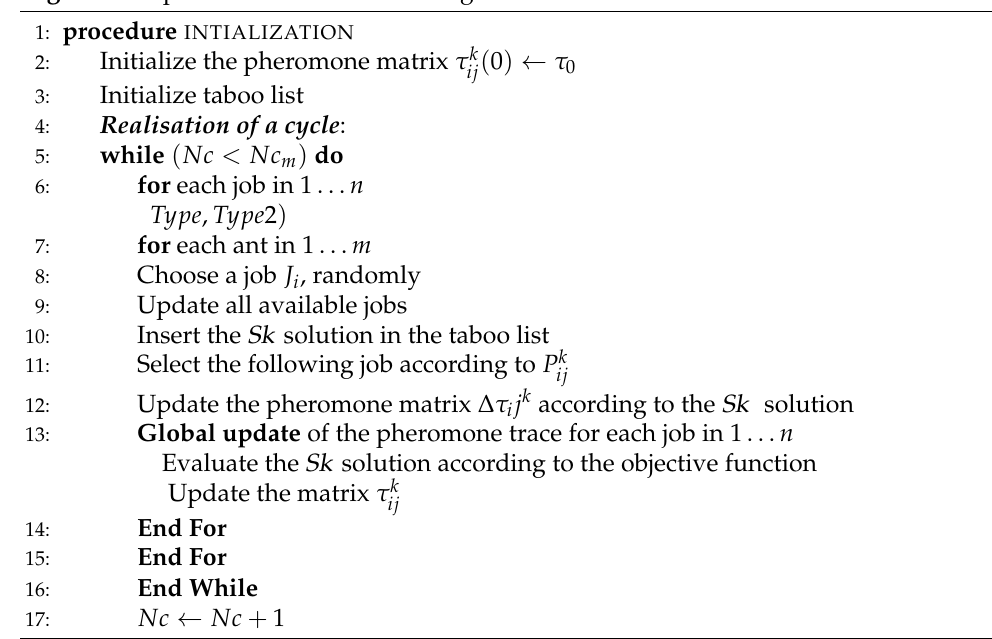
Algorithm 1 pseudo code of the ACO